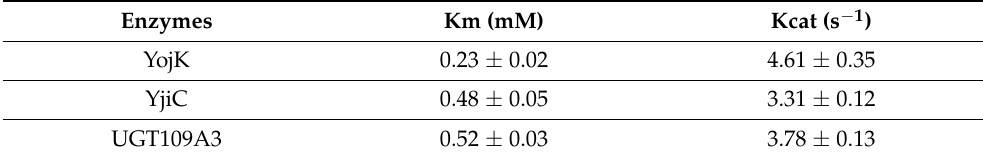
Table 2. Kinetic parameters of UGTs (Mean ± SD, n =